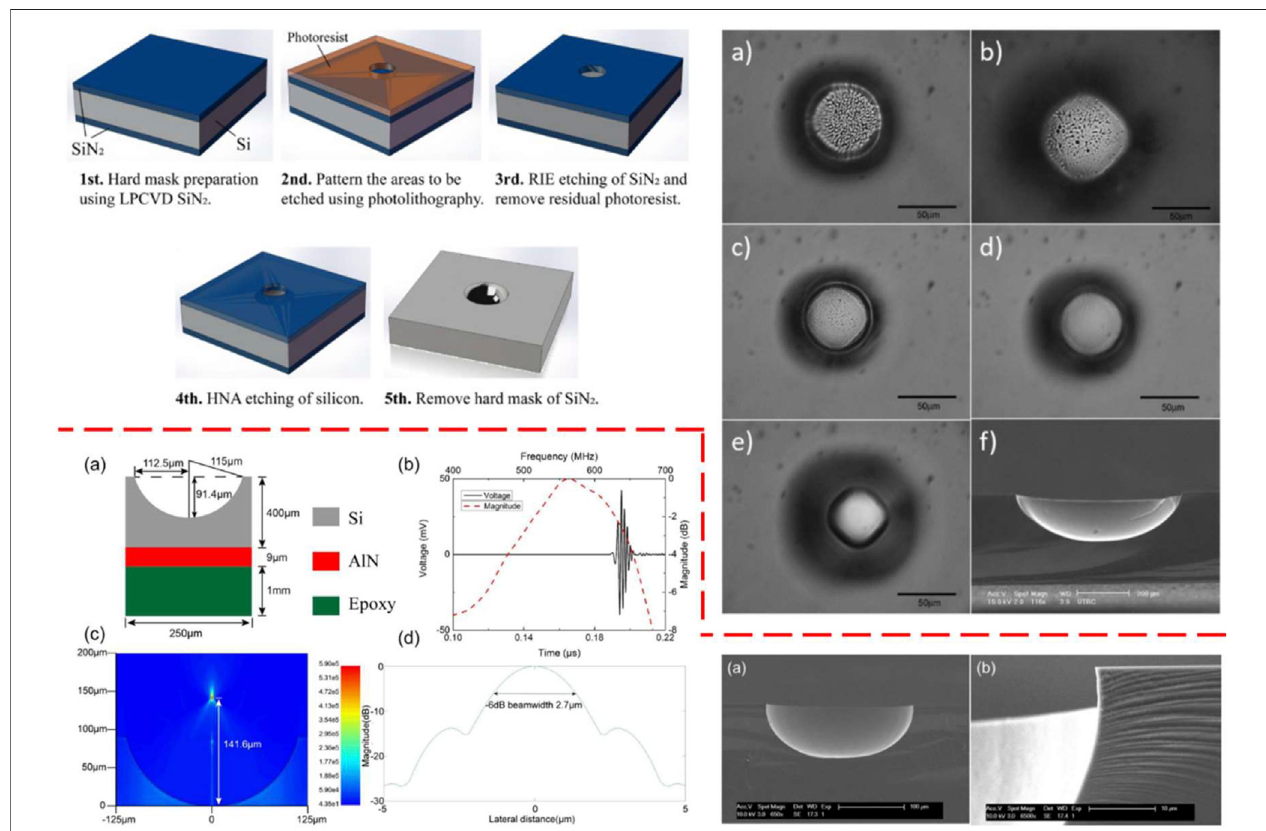
FIGURE 6 | The fl ow chart of chemical wet etching silicon lens and the SEM photographs of the silicon lens prepared by this method (top) ; silicon lens simulation and UHF device performance and the SEM photographs of dry-etched silicon lens (bottom) .